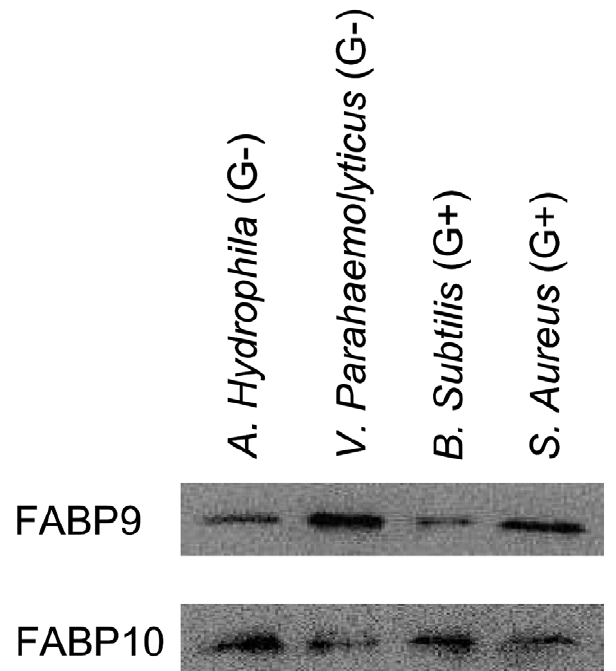
Figure 4. Binding of the microorganisms by rEs-FABP9 and rEs- FABP10. Living microbial strains, two strains of Gram-negative bacteria (G 2 ) and two strains of Gram-positive bacteria (G + ) were incubated with the proteins. Western blot analysis using His-tag antibody and the development used ECL coloration kit (KangWei, Beijing, China).